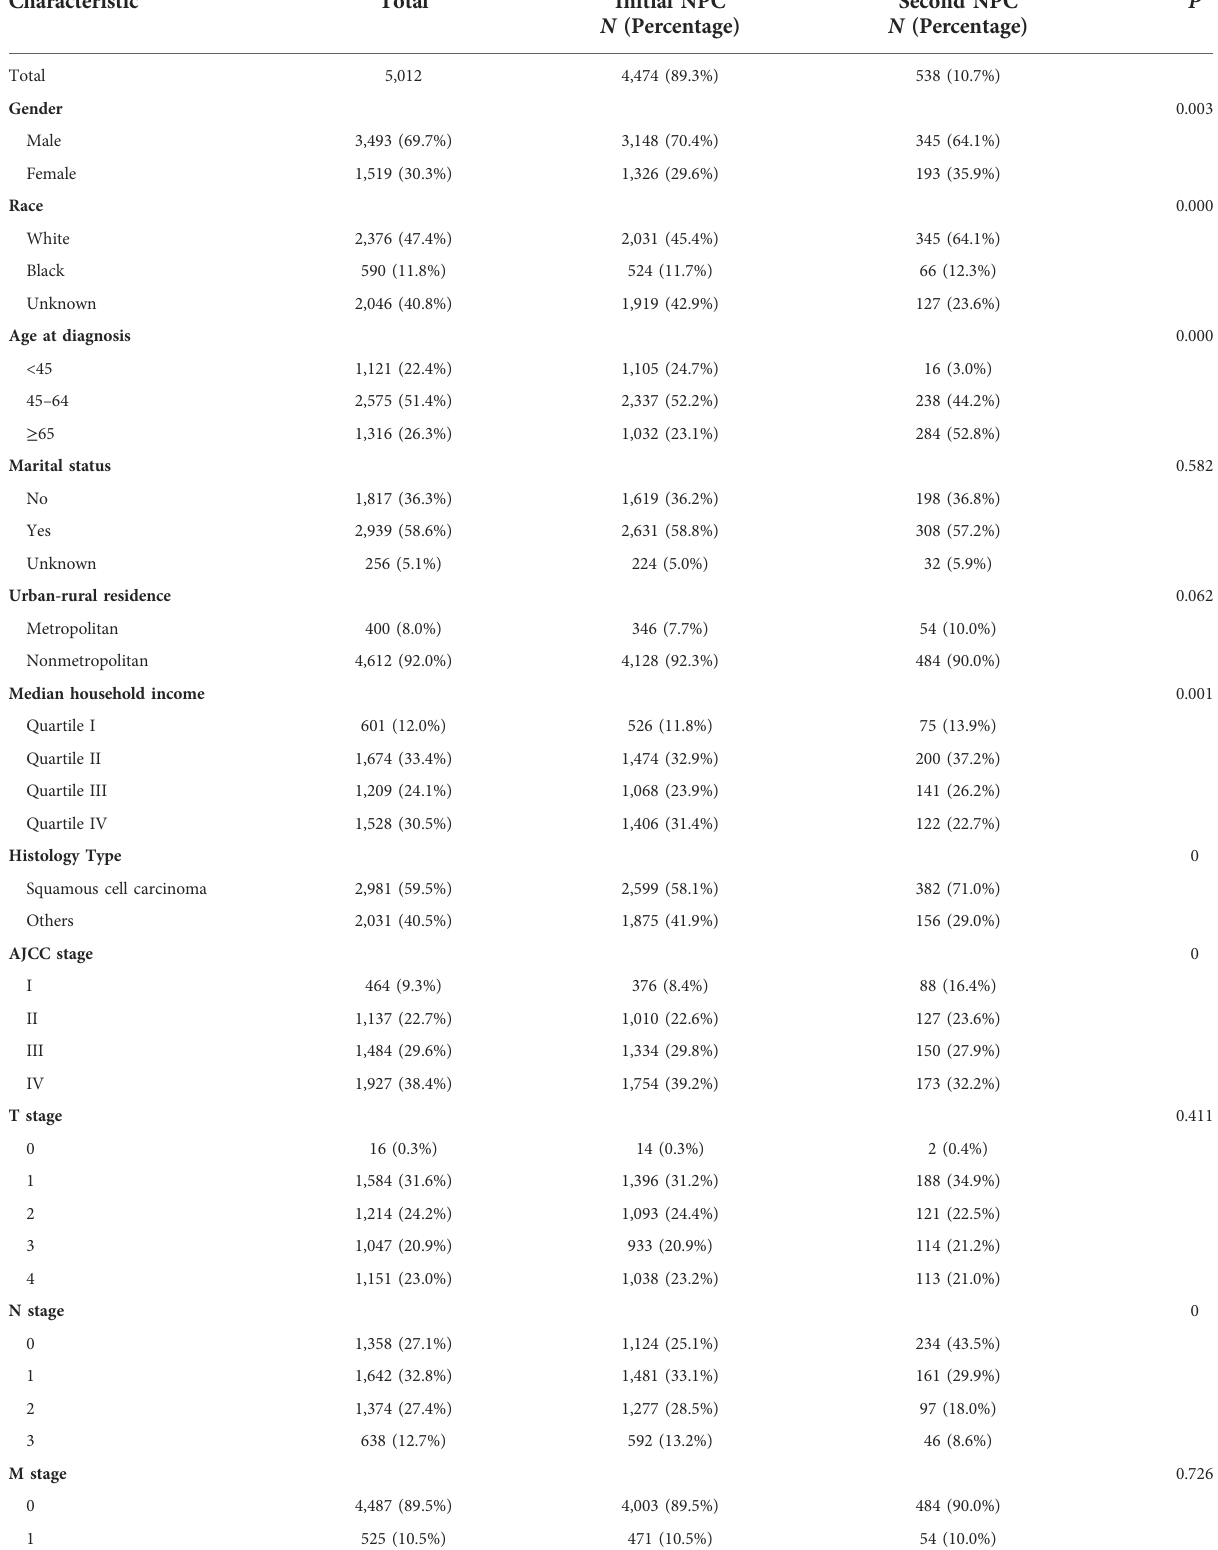
TABLE 1 Demographic and clinical characteristics of NPC